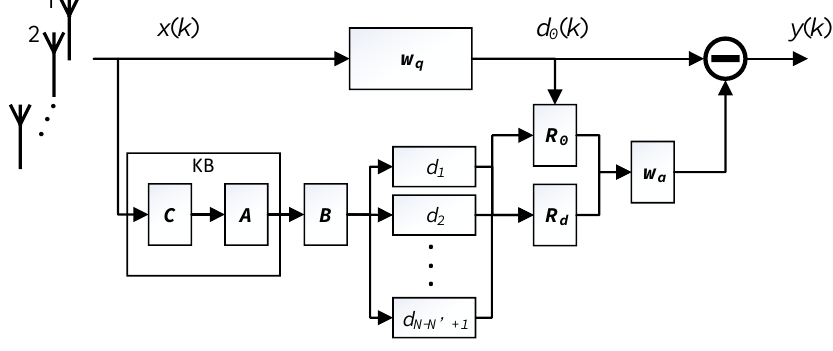
Figure 9. Framework of KB-VSSA-GSC